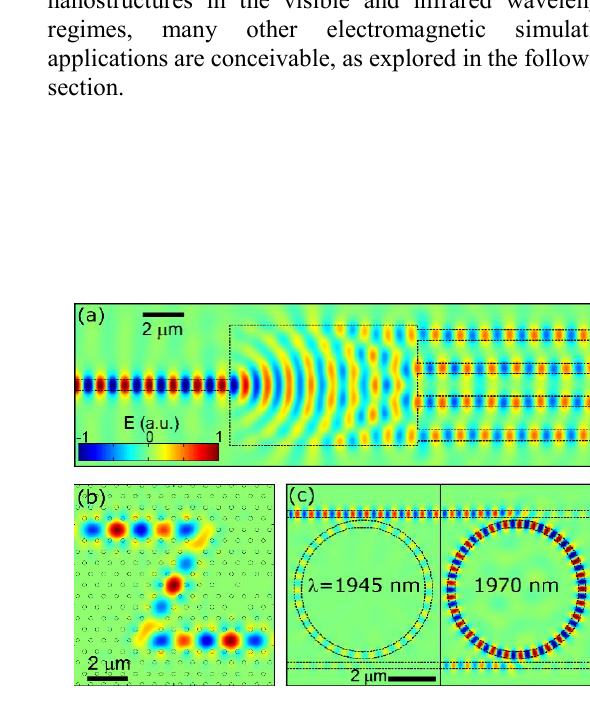
Fig. 2 Planar semiconductor (Si-air) photonic components. (a) Multi-Mode Interferometer. (b) Photonic-crystal waveguide. (c) Photonic ring resonator (modified from